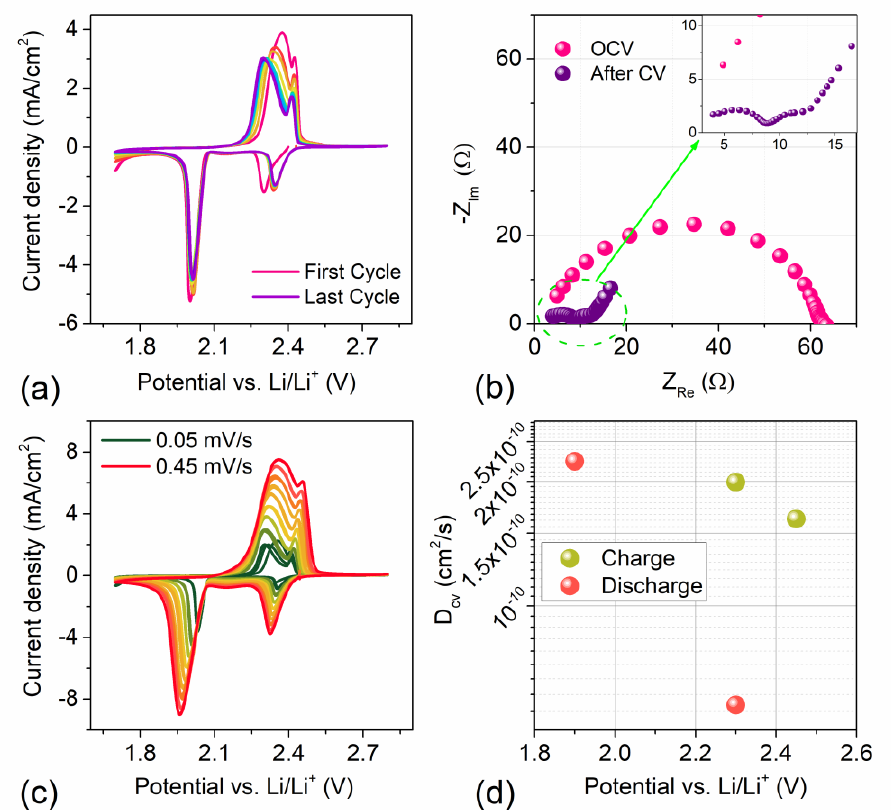
Figure 4. ( a ) Cyclic voltammetry (CV) test of S80CNH20 electrode, performed in 2032 − coin cells using DOLDME − LITFSI − LiNO 3 as electrolyte in 1.7 V – 2.8 V voltage range with a scan rate of 0.1 mV/s. ( b ) EIS conducted as assembled and after the cyclic voltammetry. ( c ) CV tests carried out at increasing scan rate (from 0.05 to 0.45 mV/s) in order to calculate the lithium diffusion coefficient D cv within the electrode material through the Randles – Sevcik equation (see Equation (1) and Figure S2 in the Supplementary Materials). ( d ) Lithium-ion diffusion coefficients obtained by using the Randles – Sevcik equation, the peak intensity ( I p ) and the scan rate (ν).